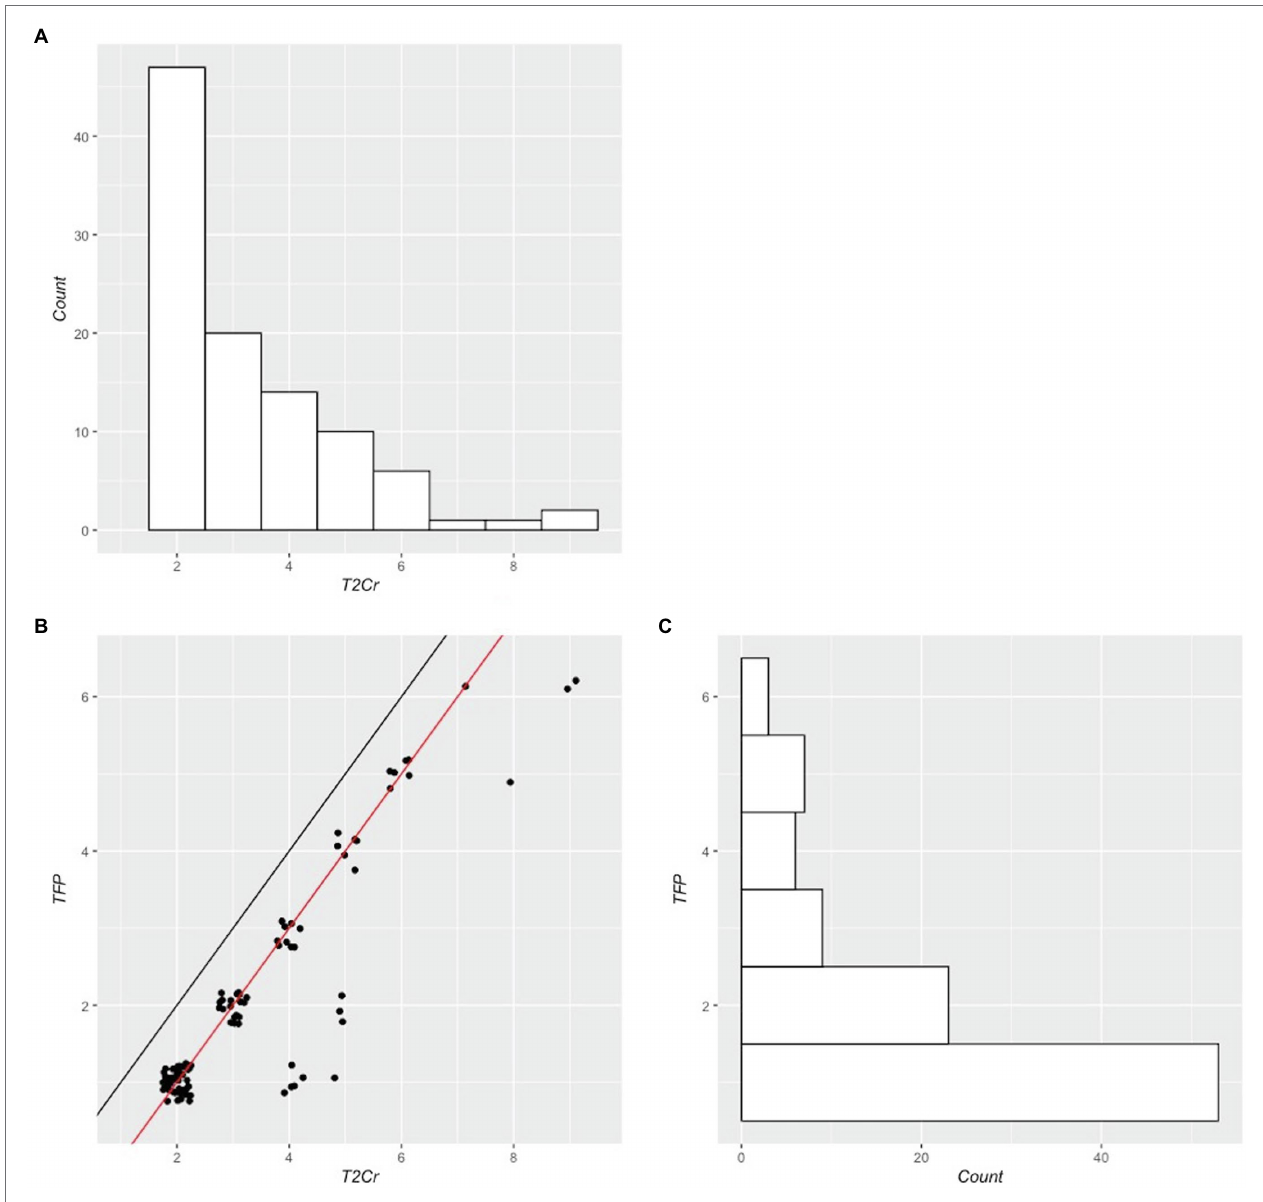
FIGURE 2 | Scatterplot (B) and marginal histograms of T2Cr (A) and TFP (C) . In B , the black diagonal line shows the unity line, and the red diagonal line shows the best possible T2Cr score for a given TFP score (i.e. when the first trial on which a perfect score is obtained is followed by another perfect score on the immediately succeeding trial). Data points below the red diagonal indicate that one or more trials contained errors after TFP was attained, suggesting unstable learning. Data points have been jittered in x and y to improve